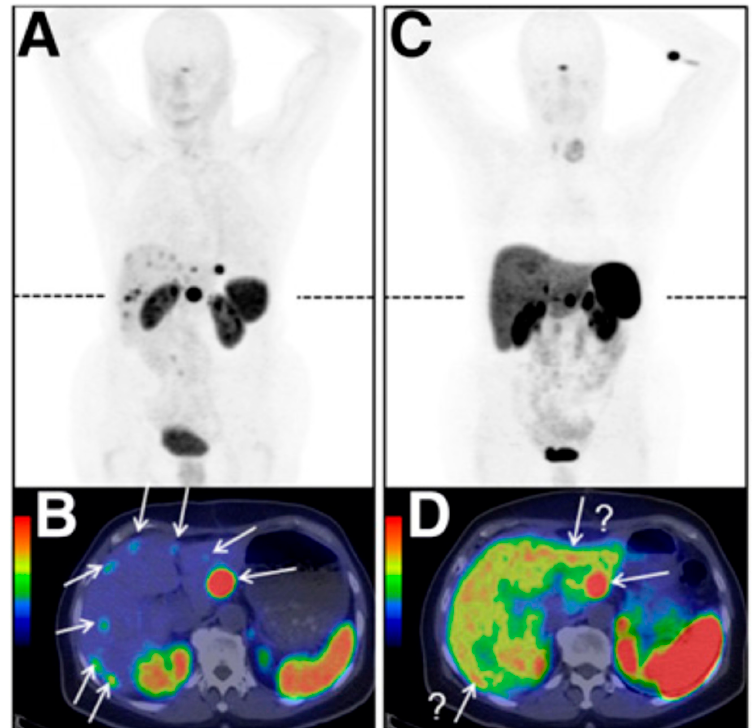
Figure 1. [ 68 Ga]Ga ‐ OPS202 PET/CT [antagonist—( A , B )] and [ 68 Ga]Ga ‐ DOTATOC PET/CT [agonist— ( C , D )] images of a patient with ileal neuroendocrine tumours , showing bilobar liver metastases (dashed lines indicate level of transaxial slices). Studies were performed on the same scanner within 2 months and show same gray (maximal ‐ intensity projections, ( A , C ) and colour scale (transaxial fusion images, ( B , D ). Importantly, background activity was lower in liver, intestine, and thyroid with [ 68 Ga]Ga ‐ OPS202 than with [ 68 Ga]Ga ‐ DOTATOC allowing better identification of the lesions in the liver which are confirmed by subsequent MRI. (Adapted from Nicolas et al., originally puplished in J Nucl Med [142]).